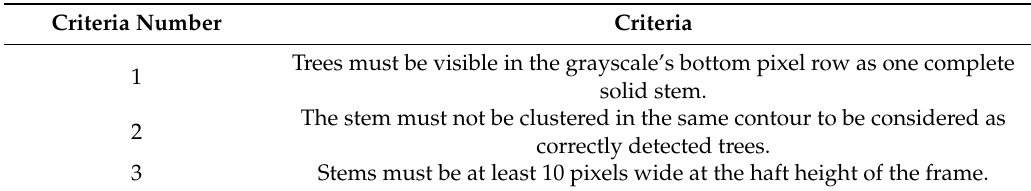
Table 3. Tree detection validation